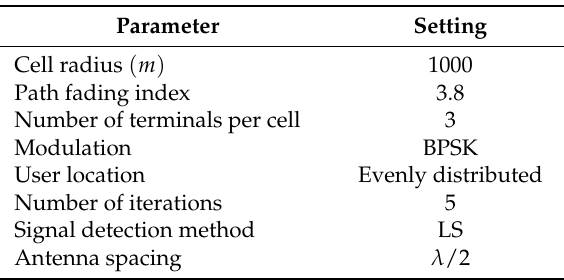
Table 2. Simulation